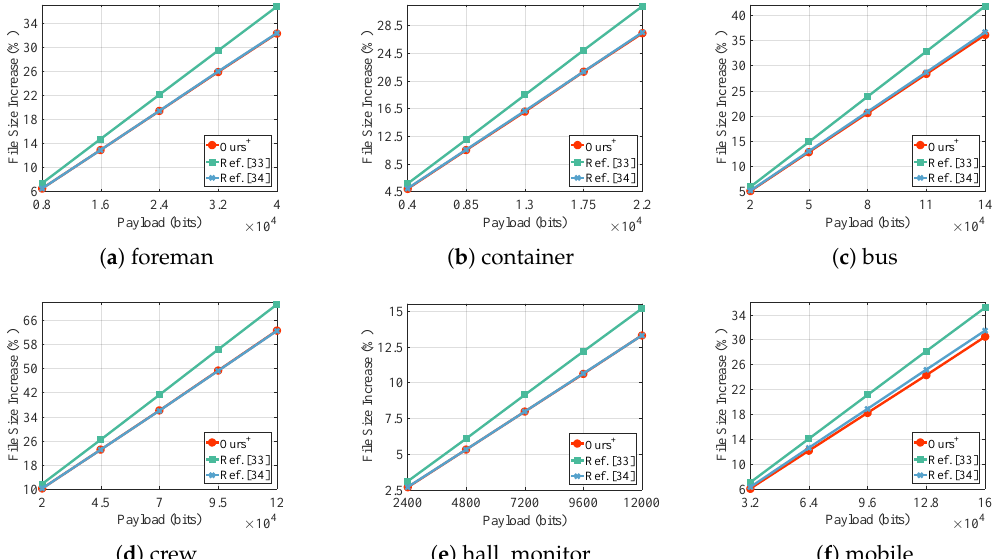
Figure 8. The increase in the file size of marked video generated by different schemes using the ( 0,0 ) coefficient pairs when QP is